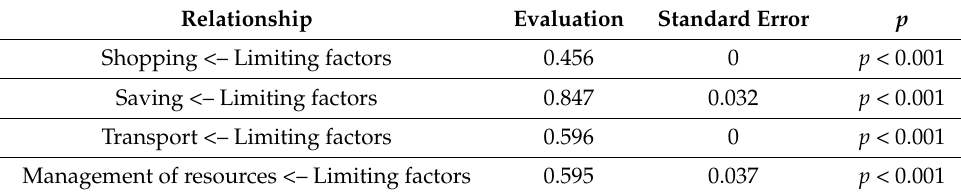
Table 13. Estimated parameters of the recursive model (Model